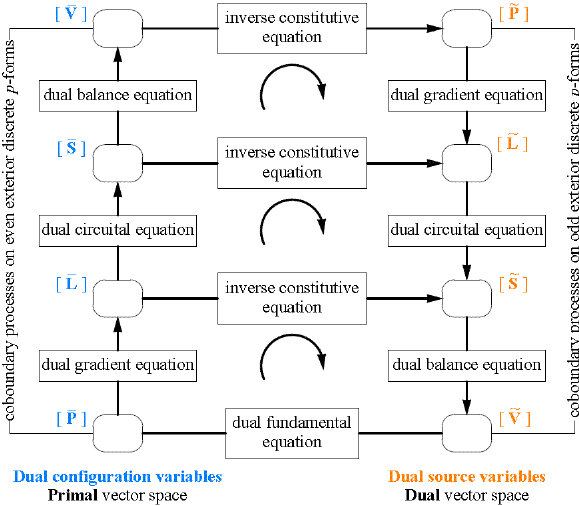
Figure 9: Classification diagram of the physical variables in the dual fundamental problem.